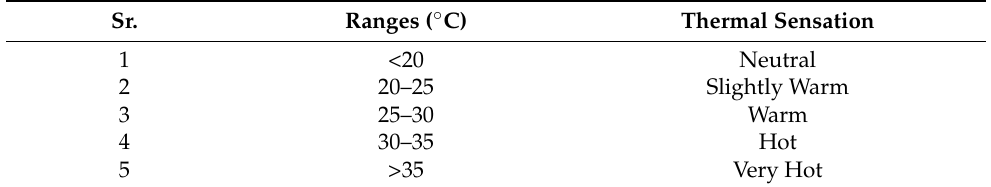
Figure 5. Spatial distribution map for change detection of ( A ) LUCC (km 2 ) and ( B ) LST (°C) during 2004–2019.